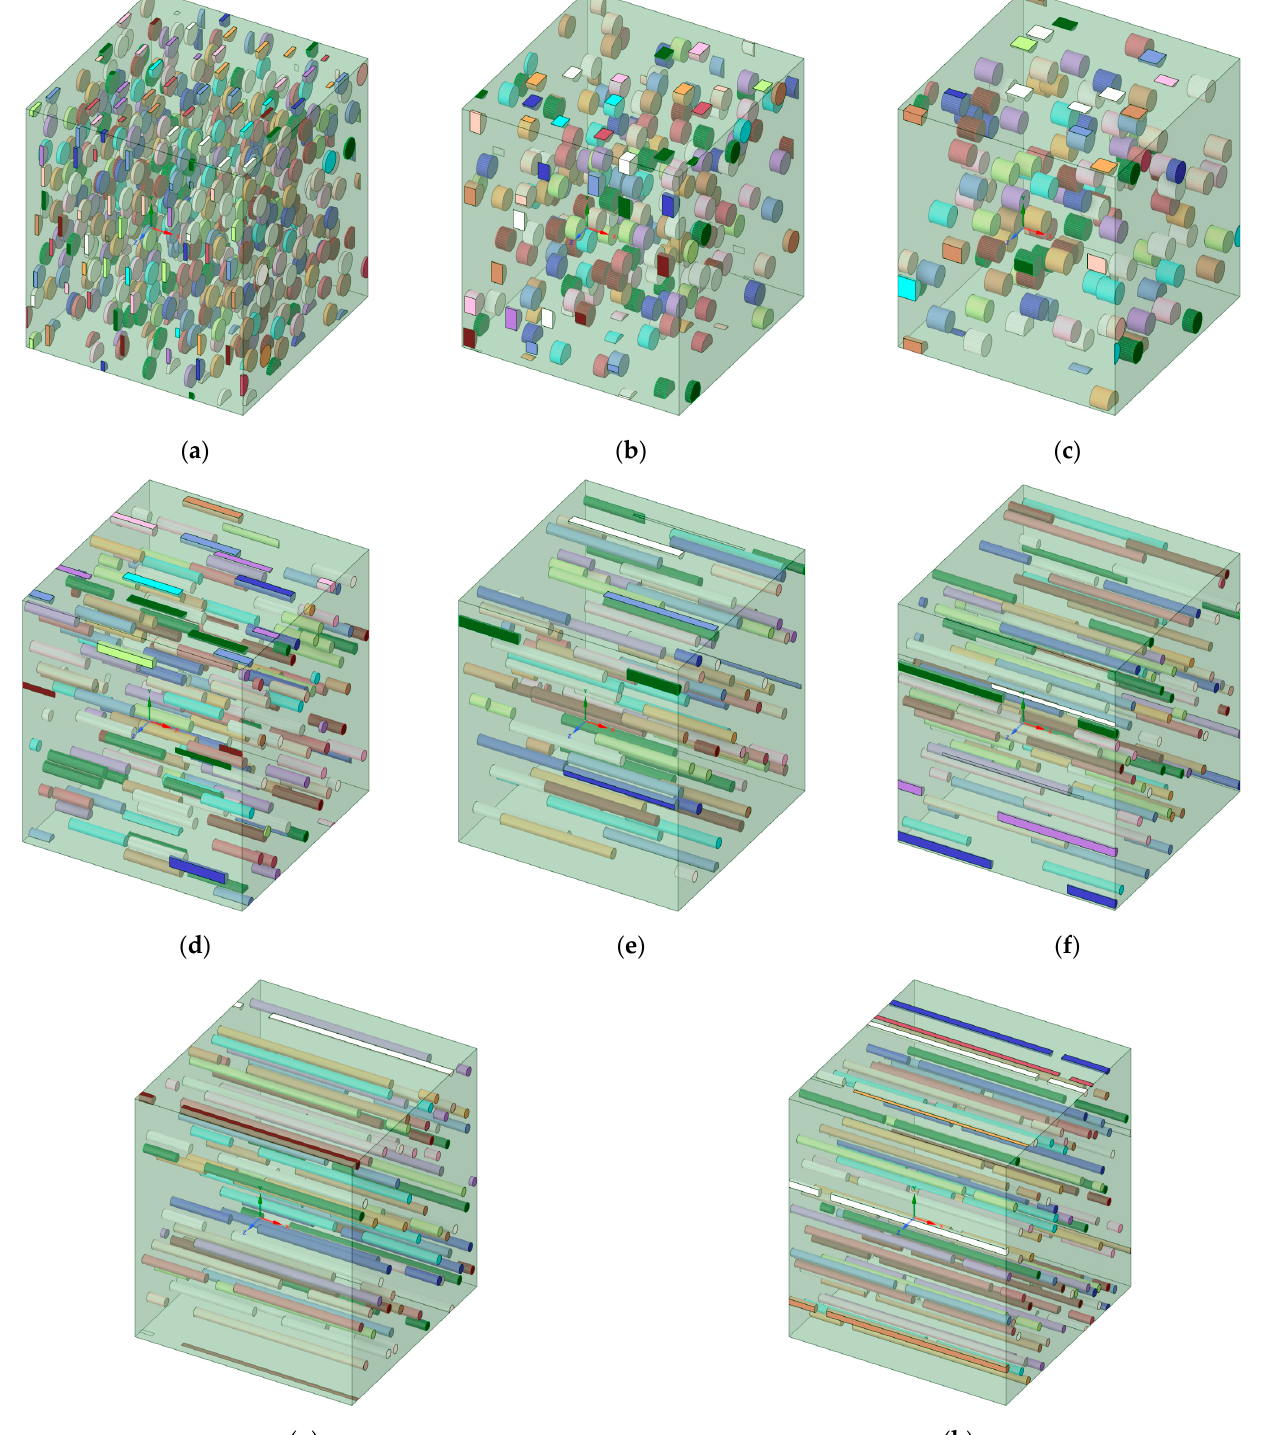
Figure 2. Finite element analysis model according to the aspect ratio of the UHMWPE fiber. ( a ) Aspect ratio 0.2, ( b ) Aspect ratio 0.6, ( c ) Aspect ratio 1.0, ( d ) Aspect ratio 6.0, ( e ) Aspect ratio 12.0, ( f ) Aspect ratio 18.0, ( g ) Aspect ratio 24.0, ( h ) Aspect ratio